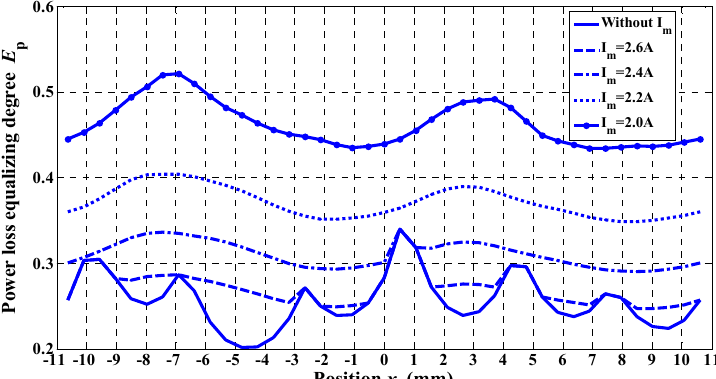
Figure 6. Power loss equalizing degree when the commutations are optimized without boundary constraint I m , with boundary constraint I m = 2.6 A, 2.4 A, 2.2 A, and 2.0 A, respectively When the commutations are optimized without boundary constraint I m and with boundary constraint I m = 2.6 A, 2.4 A, 2.2 A, 2.0 A, respectively, the local power loss distributions in position x = − 6.896 mm and x = − 4.774 mm, which are the maximum and minimum PLED positions, are as shown in Figure 7, respectively. It can be seen from Figure 7 that the maximum local power loss is gradually reduced and the local power loss distribution becomes more and more uniform, along with decrease of boundary constraint I m .